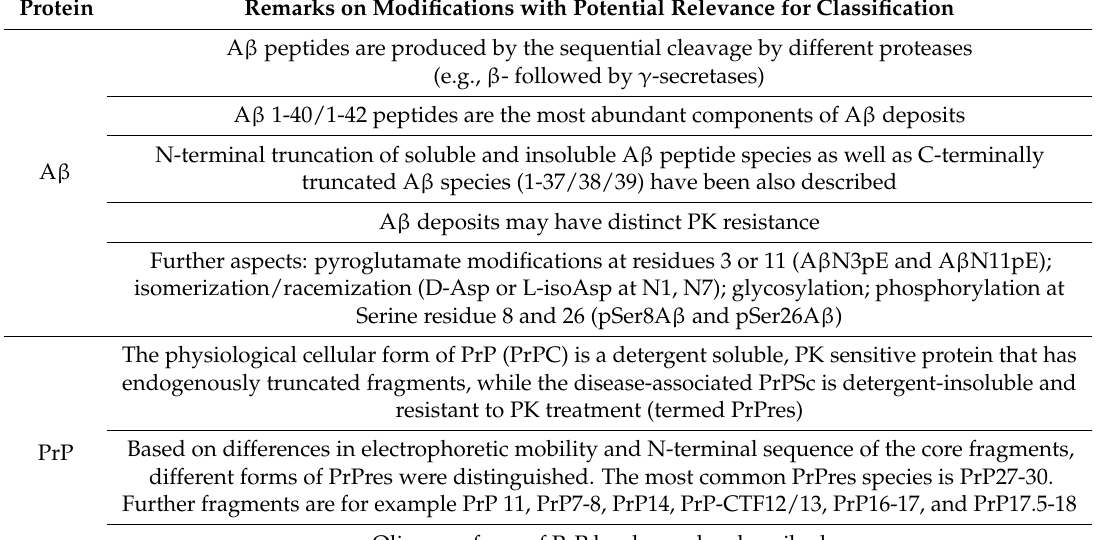
Table 2. Neurodegeneration-related proteins and their modifications with potential relevance for disease classification (summarized from references